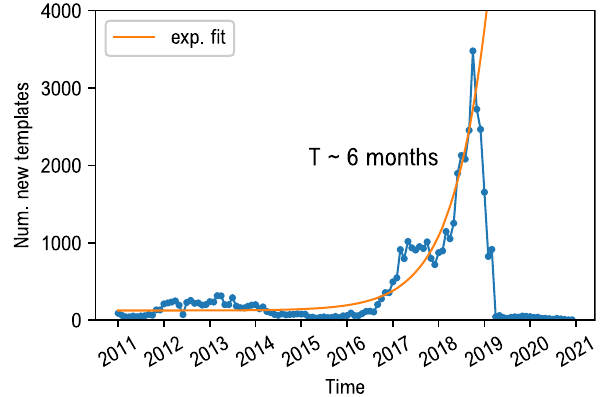
Figure 1. Evolution rate of internet memes. The number of new templates per each month is reported as a function of time. The growth rate is estimated through an exponential fit, with a doubling time of T ∼ 6